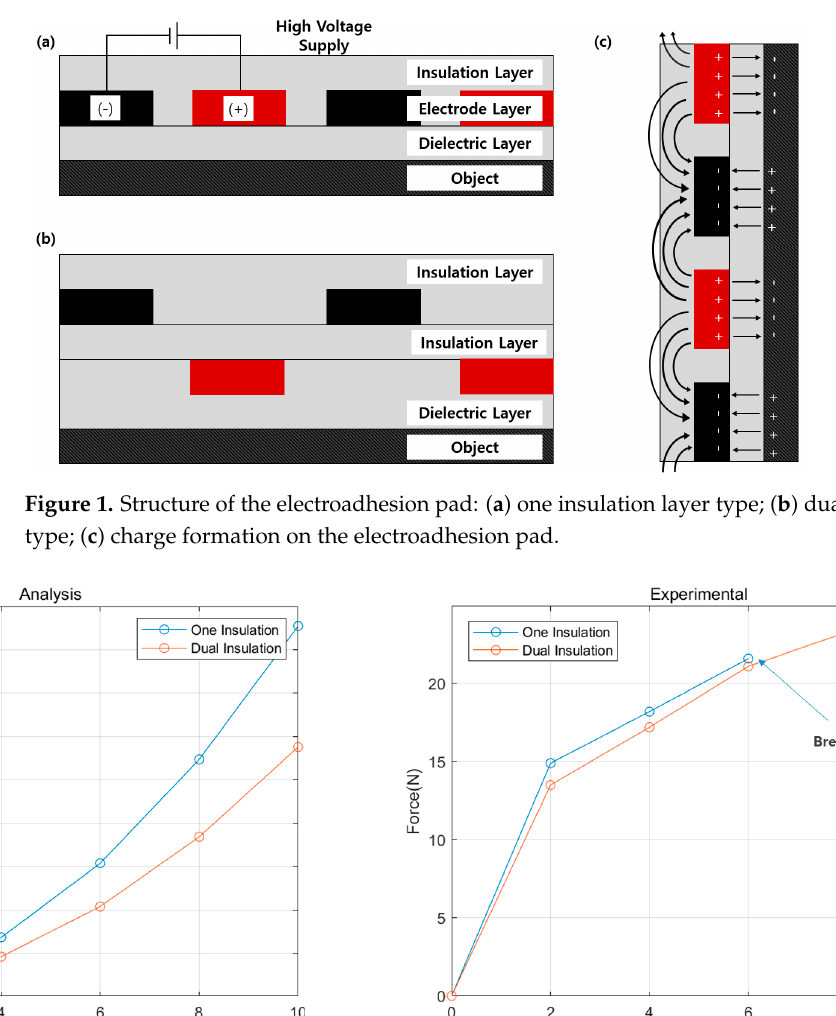
Figure 1. Structure of the electroadhesion pad: ( a ) one insulation layer type; ( b ) dual-insulation layer type; ( c ) charge formation on the electroadhesion pad.